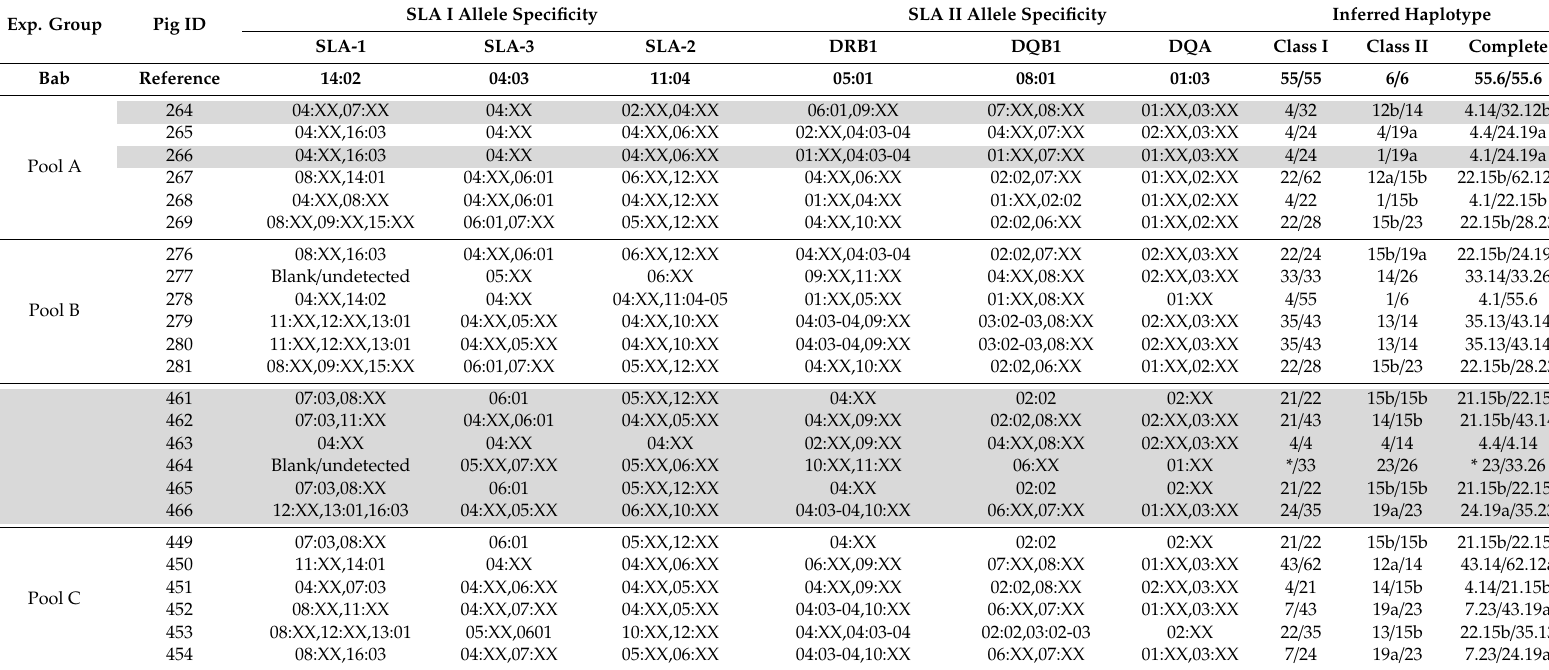
Table 3. SLA genotypes and haplotypes of pigs. Animals 264 through 269 from experiment 1 and 461 through 466 from experiment 2 were immunized with Antigen Pool A, animals 276 through 281 from experiment 1 with Antigen Pool B and animals 449 through 454 from experiment 2 were immunized with Antigen Pool C. SLA genotypes of three class I genes; SLA-1 , SLA-2 and SLA-3 and three class II genes; DRB1 , DQB1 and DQA were determined from each pig by PCR-SSP typing. SLA genotypes are shown as low-resolution allele groups (e.g., SLA -1*04:XX), intermediate-resolution allele strings (e.g., DRB1 *04:03–04) or specific high-resolution alleles (e.g., DQB1*02:01), for example, pig 266 bears the SLA-1*16:03 allele and one of the SLA-1*04:XX group alleles; up to two di ff erent alleles from the SLA-3*04:XX group; and one allele from the SLA-2*04:XX group and one from the SLA-2*06:XX. The inferred class I and class II SLA haplotype is also shown for each pig, with the high-resolution haplotype data for the Babraham (Bab) shown for reference. Pigs that recovered after challenge are highlighted by grey shading. Exp. Group Pig ID SLA I Allele Specificity SLA II Allele Specificity Inferred Haplotype